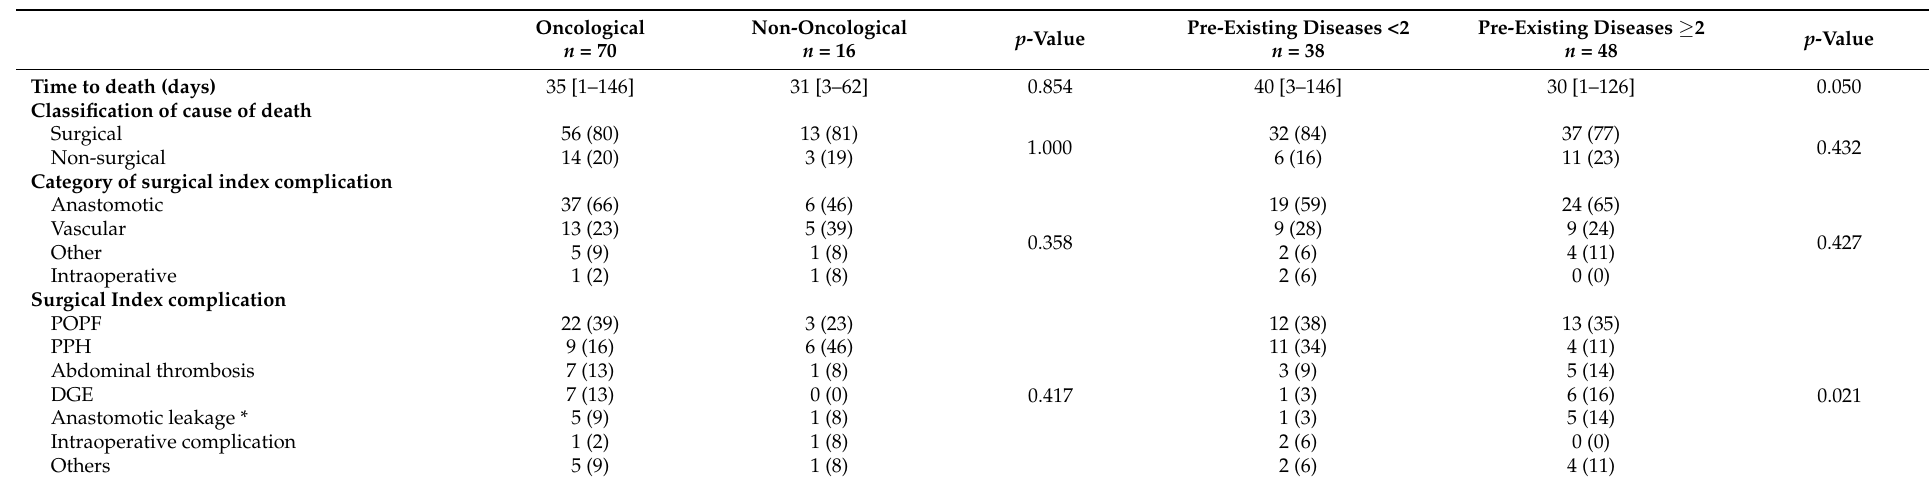
Table 4. Distribution of questionnaire responses according to patient